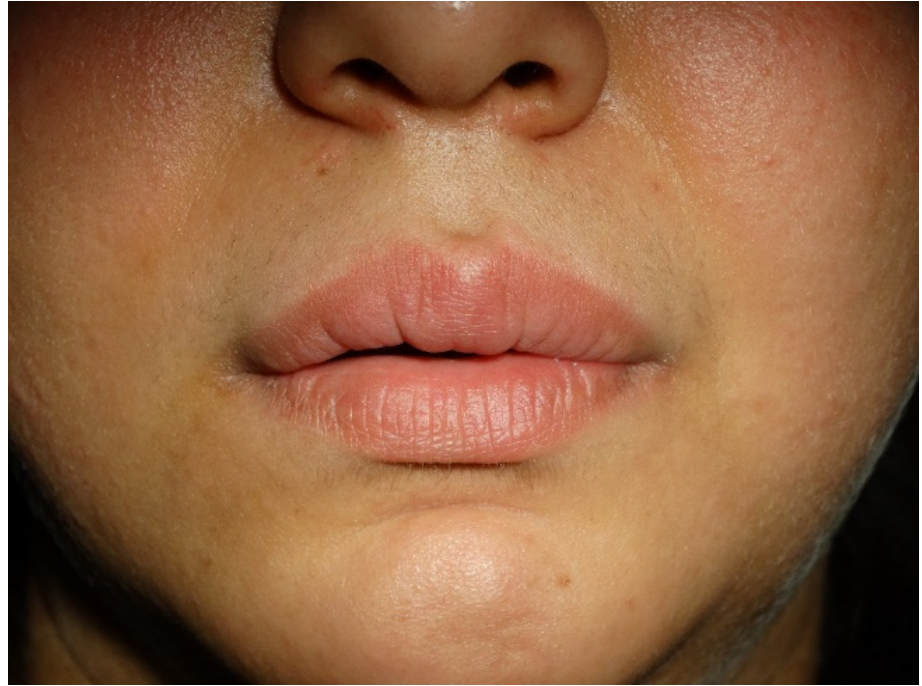
Figure 3. Posttreatment view of the patient with marked improvement of upper lip swelling and erythema after five months of Isoniazid monotherapy.